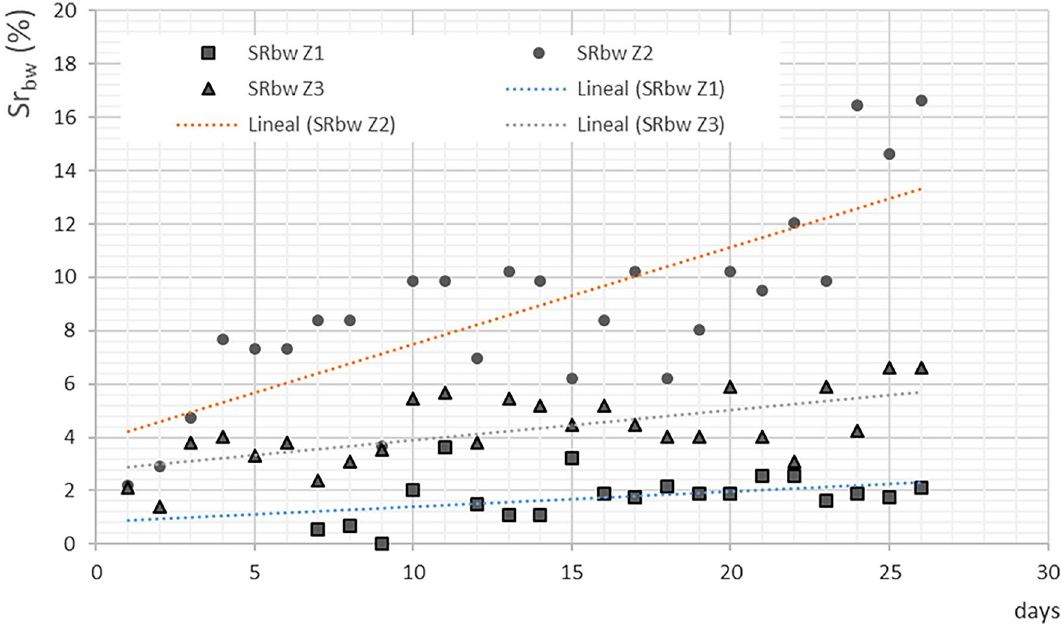
Figure 3. Variation in the SR bw over